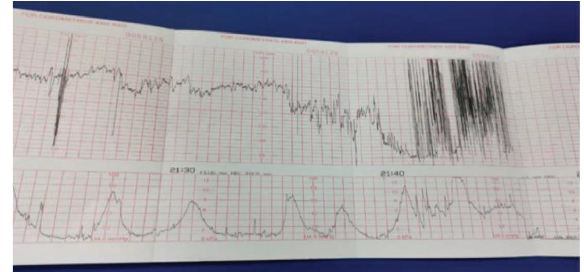
Figure 1: CTG of the patient before shifting for emergency ce- sarean